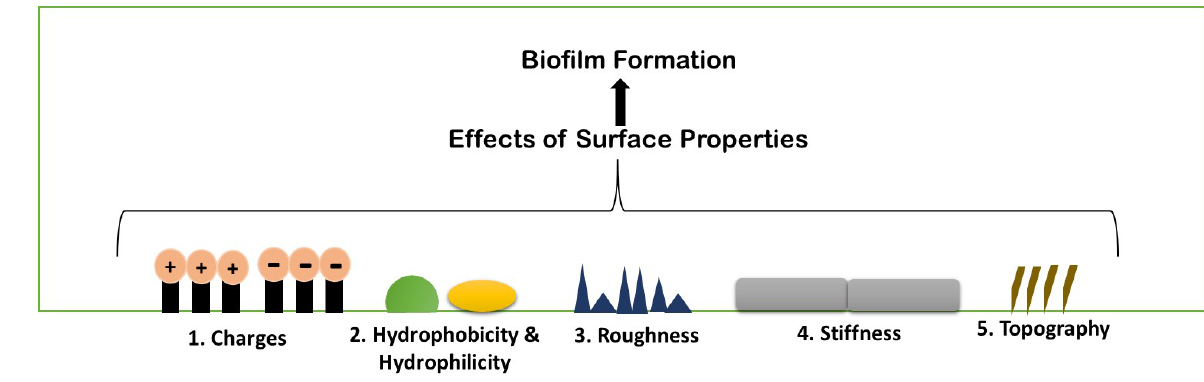
Figure 4. Schematic illustration of different existing properties of surface or biofilm formation.